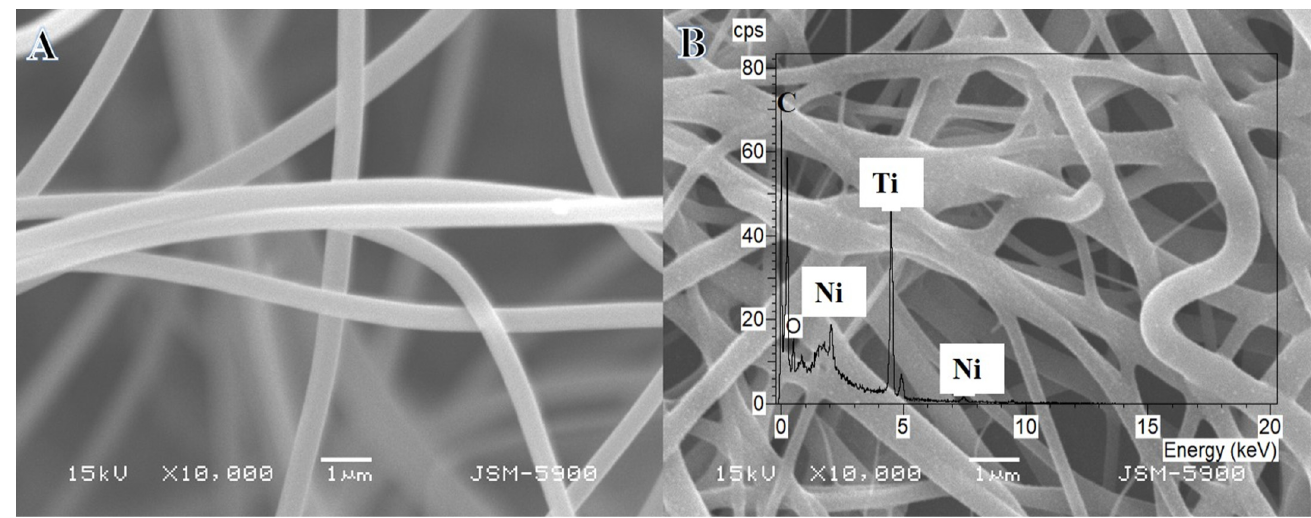
Figure 1. SEM images of the electrospun NiAc/TiIP/PVP nanofiber mats after drying at 50 °C over- night ( A ) and the produced NiTiO 3 /TiO 2 -decorated CNFs after calcination in argon at 800 °C ( B ).